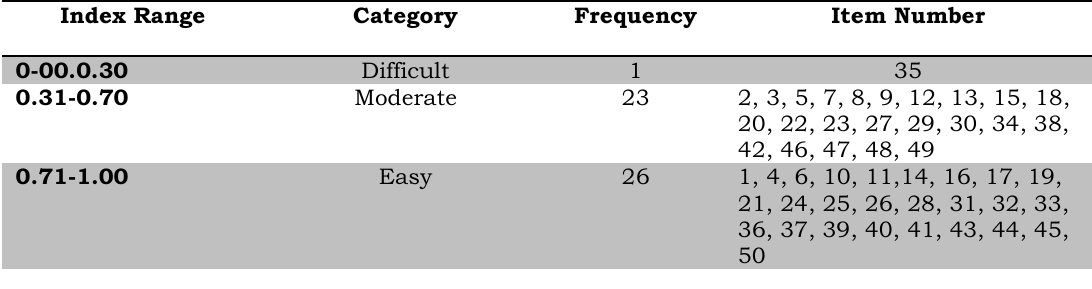
Table 4. The Category of Level of Difficulty (LD) of the Test Items